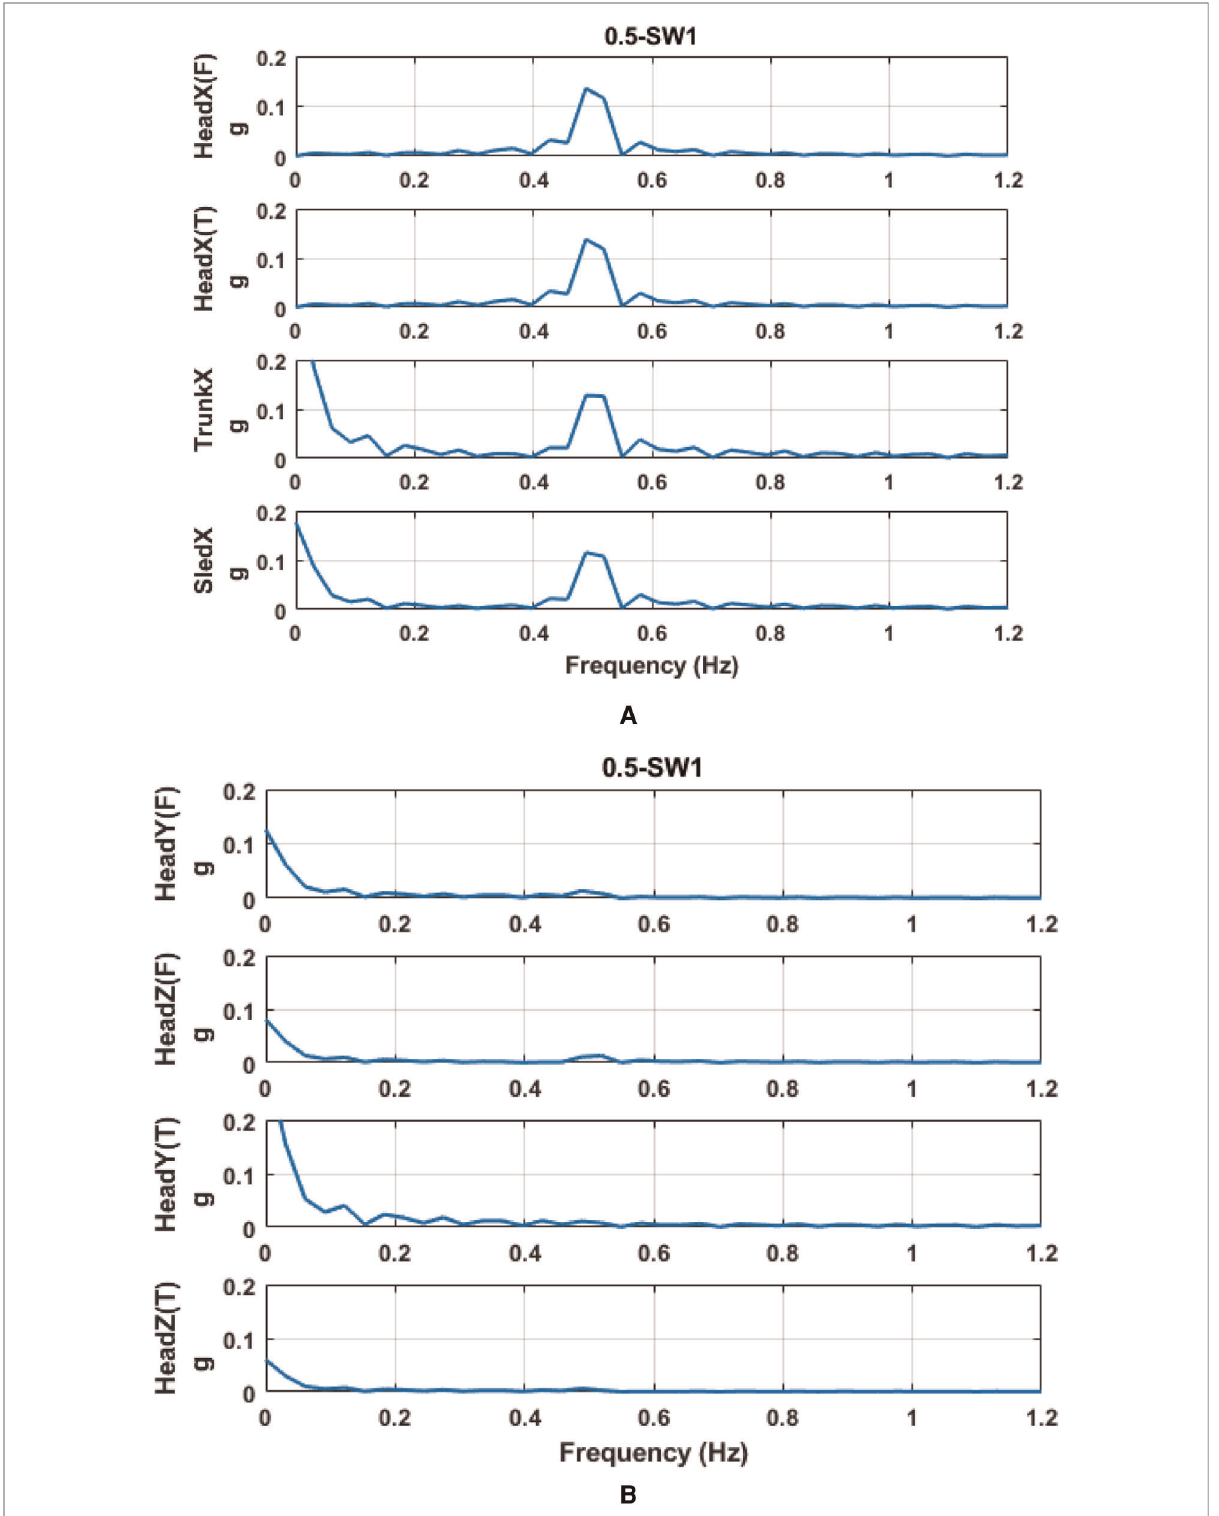
FIGURE 8 Frequency spectrum of acceleration at 0.5 Hz and SW. ( A ) principal direction and ( B ) secondary direction. T and F on Y-axis labels mean the acceleration measured at the frontal part of the head and the acceleration measured at the temporal part of the head,